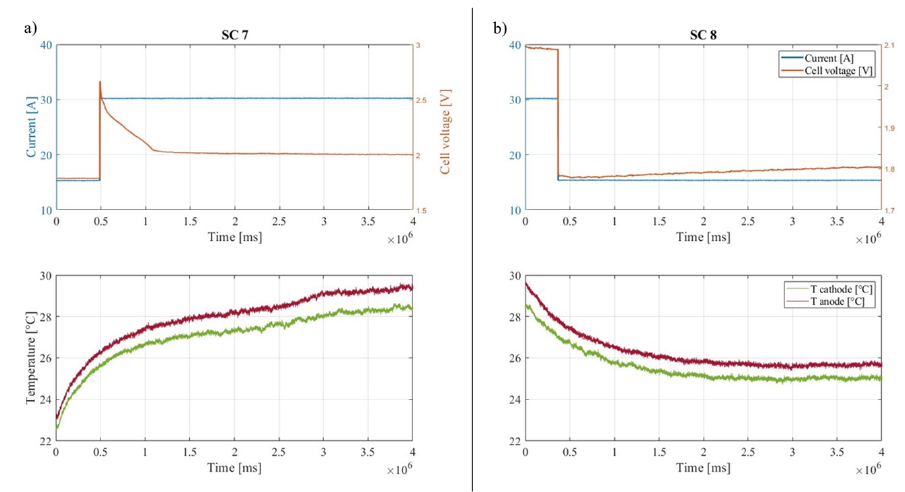
Figure 9. Obtained experimental results: ( a ) SC7 (15–30 A), and ( b ) SC8 (30–15 A).